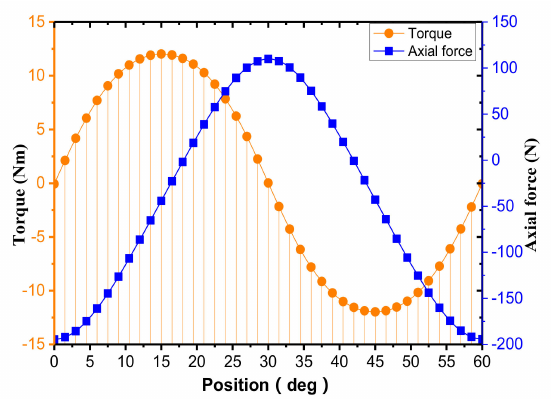
Figure 5. Pull-out torque and the axial force of the initially designed CPMC obtained by 3D-FEM.